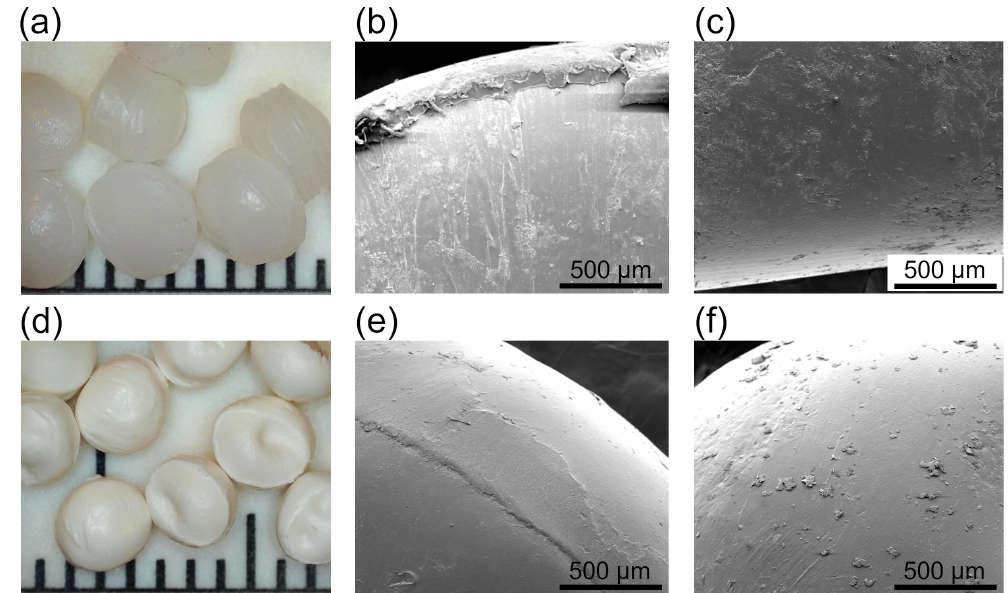
Figure 8. Granules of POM ( a ) and PC+ABS ( d ). One division on the scale equals 1 mm. SEM micrographs of a granule’s surface in the as-received condition for POM ( b ) and PC+ABS ( e ). Surface of granule after 2000 cycles in compression for POM ( c ) and PC + ABS ( f